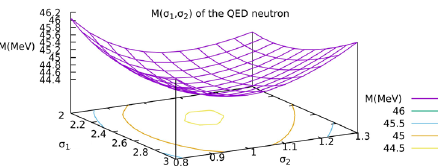
Figure 1. The mass M of the QED neutron as a function of the variationparameters σ 1 , and σ 2 . TheQEDneutronhasanenergy minimum at M = 44 . 5